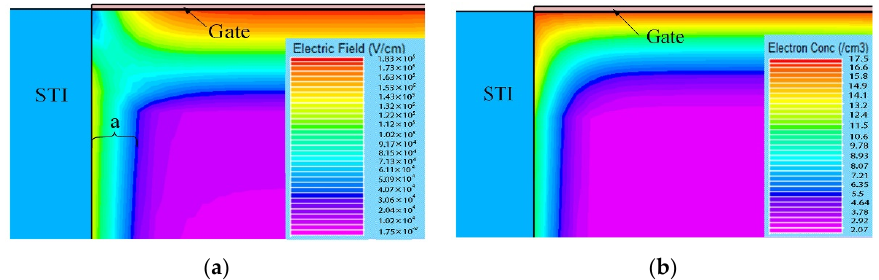
Figure 12. Device simulation results (STI in the gate width direction): ( a ) electric field and ( b ) electron density of the STI side.